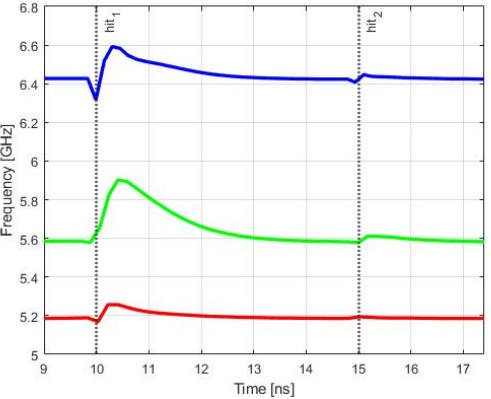
Figure 5. Effect on the VCO free-running frequency, of two different particles’ hits. The two hit instants, hit 1 and hit 2 , correspond to particle energy of 60 and 5 MeV · cm 2 /mg, respectively. The effects with three different values of the control voltage are also reported: 0 V (red Line), V DD /2 (green line), and V DD (blue line).